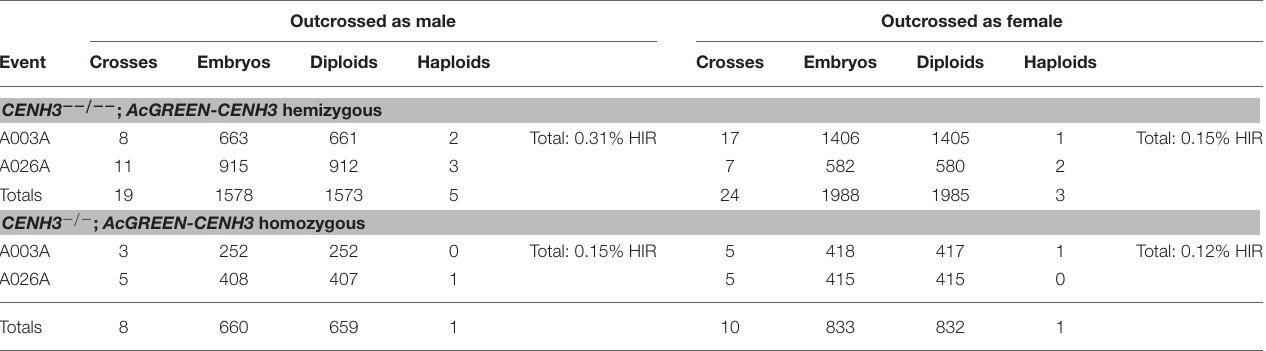
TABLE 3 | Haploid induction frequency determination in CENH3 − / − lines complemented by one (top) or two (bottom) AcGREEN-CENH3 copies. Outcrossed as male Outcrossed as